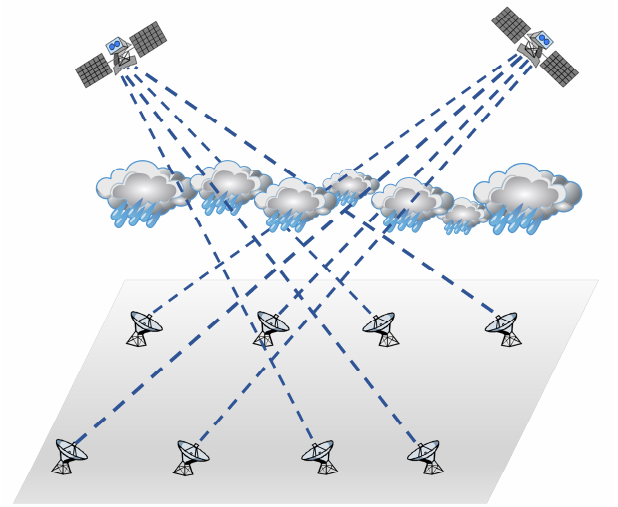
Figure 2. Schematic of joint monitoring of rainfall by multiple ESLs in the area The core of reconstructing the rainfall field using the ESL network is how to recon- struct the complete rainfall field in the area from sparsely distributed rainfall information measured by the ESL network, and the process can be represented as